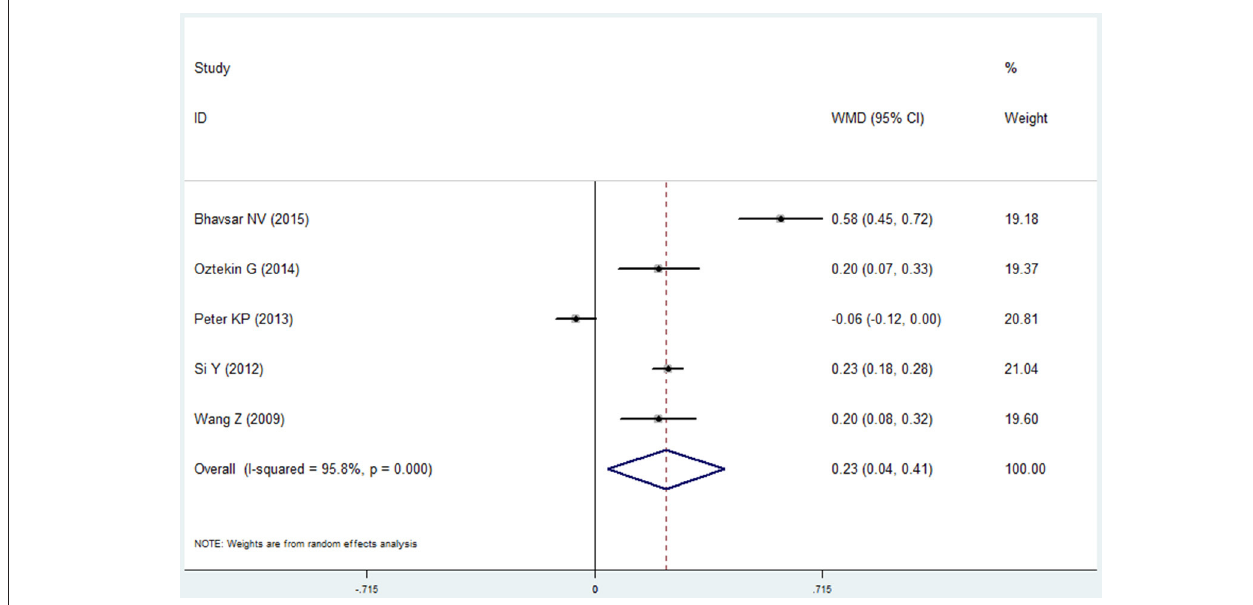
FIGURE 5 | Forest plot of the mean difference in plaque index between the COPD and non-COPD groups.